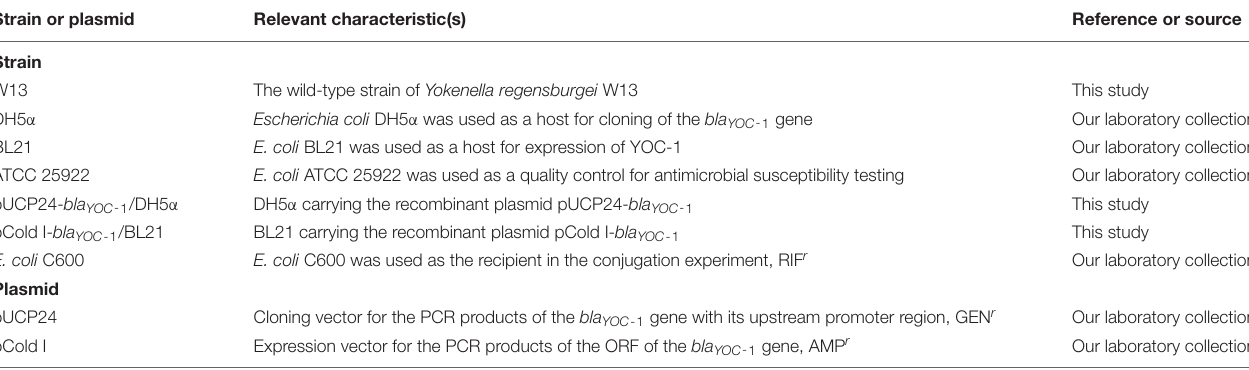
TABLE 1 | Bacteria and plasmids used in this